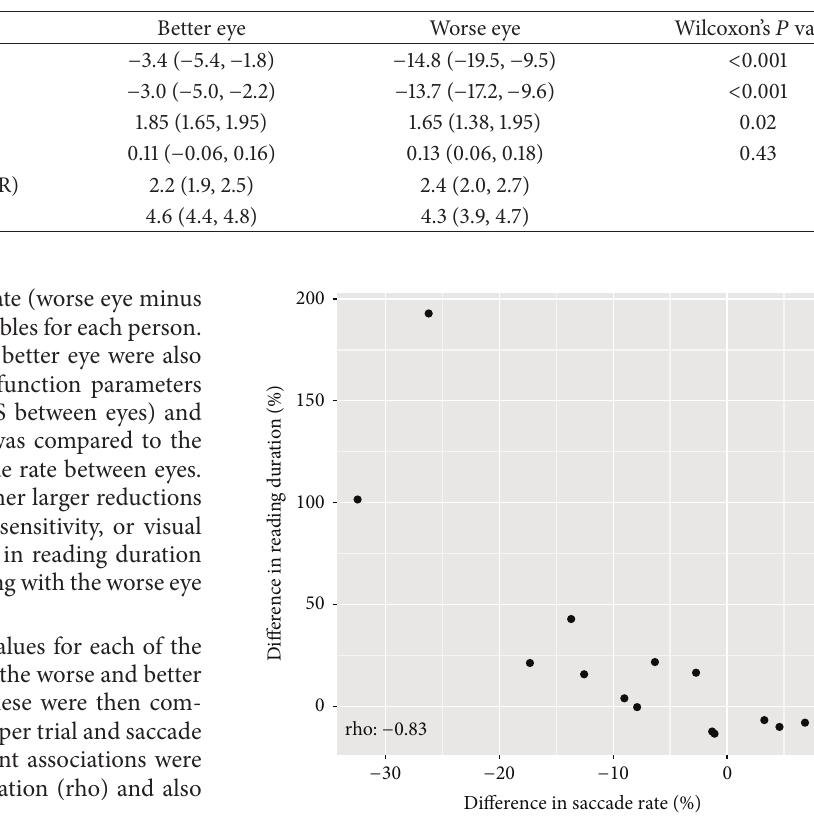
Figure 3: Scatterplots depicting the statistically significant relation- shipsbetweenthepercentagedifferenceinreadingdurationbetween the worse eye and the better eye and the percentage difference in saccade rate between the worse eye and the better